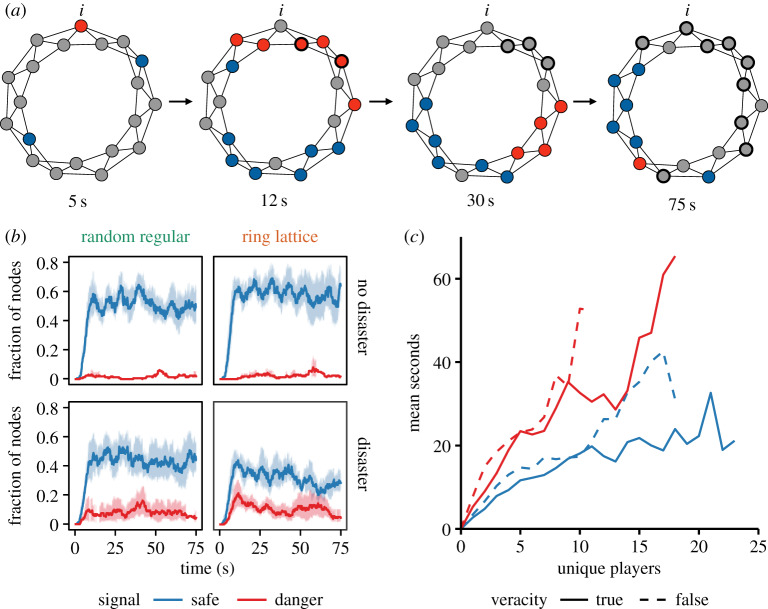
Safe signals exceed danger signals, whether a ‘disaster’ strikes or not. (a) An example of the spreading of signals in the game. The figures are snapshots at 5, 12, 30 and 75 s in a 20-node ring-lattice network with a ‘disaster’ striking at the end (see movie S2 for full animation). Each node's colour shows the signal choice made by subjects at the indicated time (blue for ‘Safe’ and red for ‘Danger’). The label ‘i’ indicates the informant's node. Bold nodes indicate subjects who have evacuated at the time, but, in the actual game, neighbours were not informed of their evacuation. In this session, nine of 20 subjects successfully evacuated before the disaster struck. (b) Average fraction of nodes showing safe signals (blue lines) and danger signals (red lines) over time in 20-node networks (including evacuated subjects in the denominator) (see electronic supplementary material, figure S4 for networks of other sizes). Shading indicates 95% confidence intervals among network sessions (N = 8). (c) Speed of spread of information, by signal type and accuracy. The curves indicate the number of seconds it takes for signal cascades to reach any number of unique players in a network in all of the experimental network sizes combined. While the speed varies with signal type (p < 0.01; Kolmogorov–Smirnov test), with safe signals spreading faster, there is no detectable difference by signal accuracy (p = 0.26; Kolmogorov–Smirnov test). Safe signals in blue, danger signals in red. (Online version in colour.)